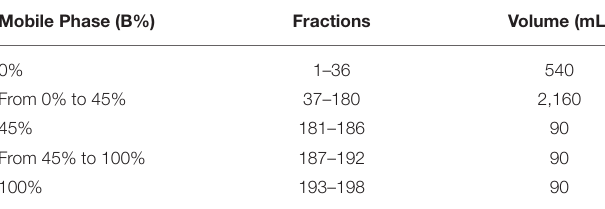
TABLE 1 | Mobile phase used for the first step of OC purification.